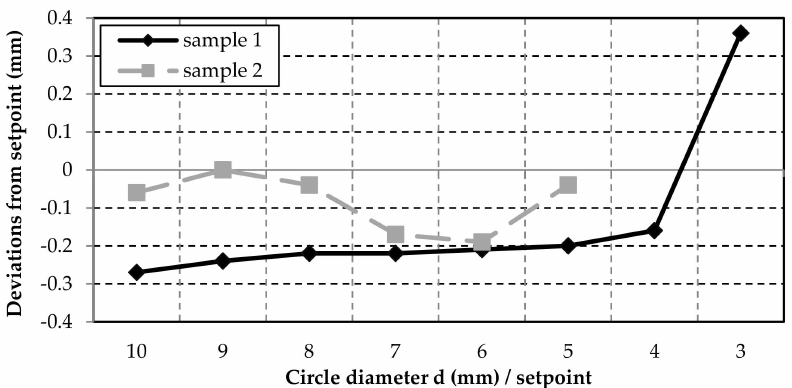
Figure 8. The deviations from the set point of the inner (Sample 1) and outer (Sample 2)